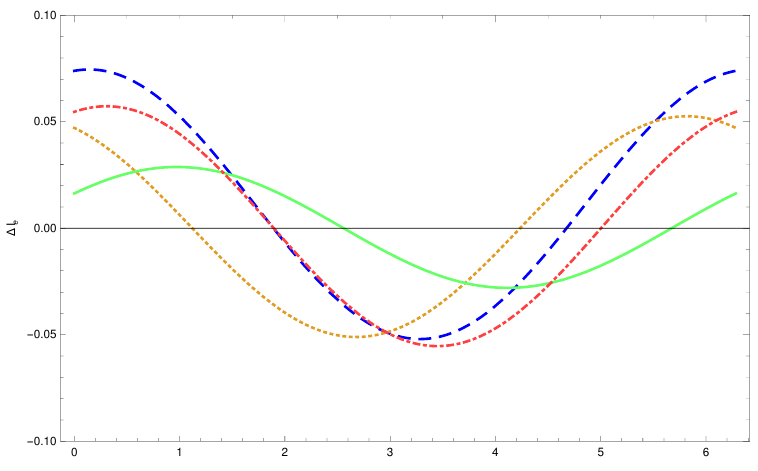
Figure 9 . (cid:1) I e ( E 1 ; E 2 ; (cid:18) ) as a function of the phase (cid:14) for E 1 = 400 MeV, E 2 = 1000 MeV and several chosen values of azimuthal angle: (cid:18) = 0 : 12 (cid:25) (blue dashed line), (cid:18) = 0 : 18 (cid:25) (orange dotted line), (cid:18) = 0 : 25 (cid:25) (green solid line) and (cid:18) = 0 : 39 (cid:25) (red dot-dashed line). Normal mass ordering is